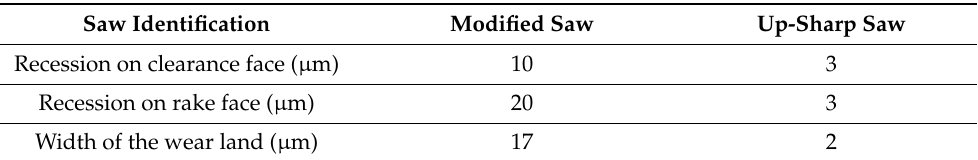
Table 7. Initial measurements at 0 min on the clearance face, rake face, and the width of the wear land of the